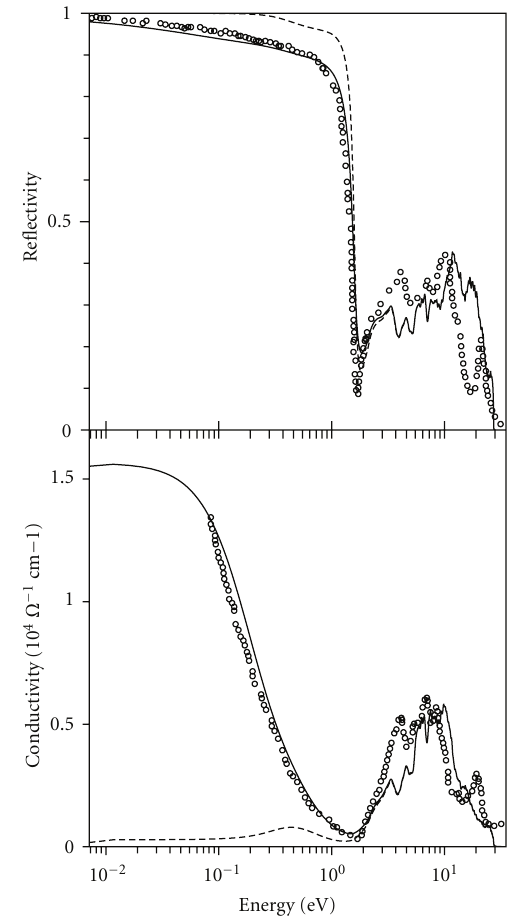
Figure 58: Calculated optical reflectivity R ( ω ) and diagonal part of the optical conductivity σ 1 xx ( ω ), of LuB 12 in the LSDA approxi- mation: dashed line without and solid line with Drude term [349] compared with the experimental data (open circles) [358]. Above ∼ 1eV the dashed and solid lines